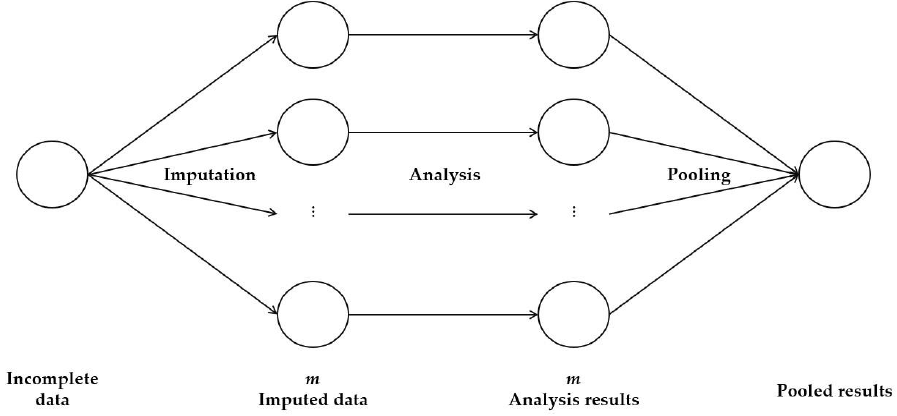
Figure 3. Example of multiple imputations.